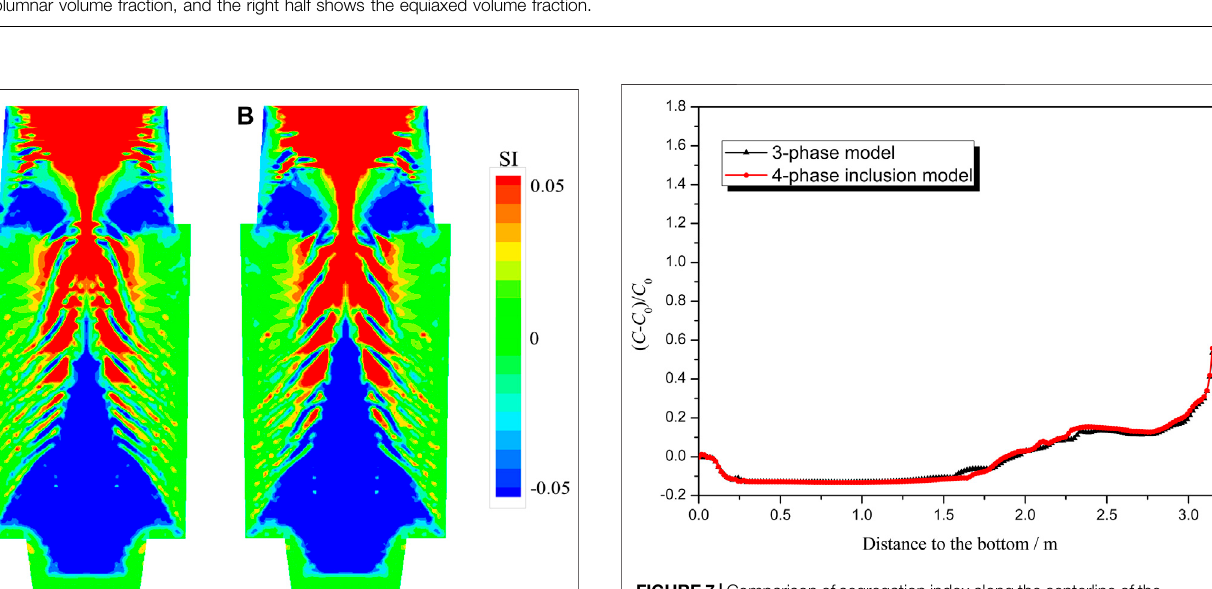
FIGURE 5 | Predicted inclusion distribution and growing process of columnar and equiaxed crystals in the 36-ton ingot with the four-phase inclusion model at different times: (A) 0.5 h, (B) 2 h, (C) 5 h, (D) end of solidi fi cation. Inclusion particles are represented by colored dots with different diameters. The left half shows the columnar volume fraction, and the right half shows the equiaxed volume fraction.